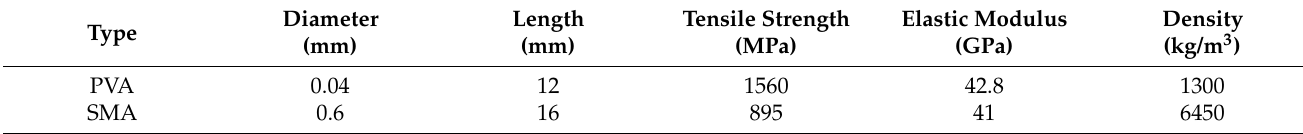
Table 3. Mechanical properties of PVA and SMA